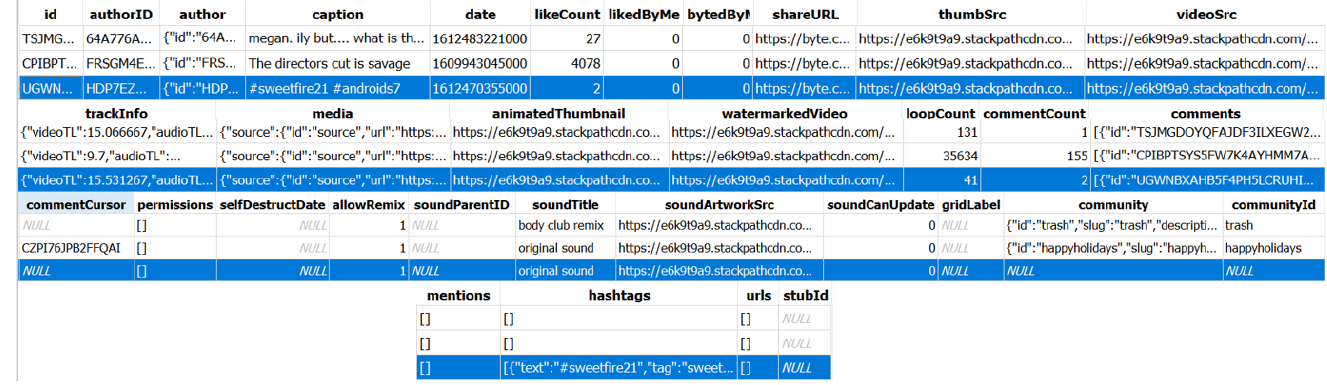
Figure 4. Byte’s Android video-related attributes stored in byte.db\Post recovered from as shown in DB Browser